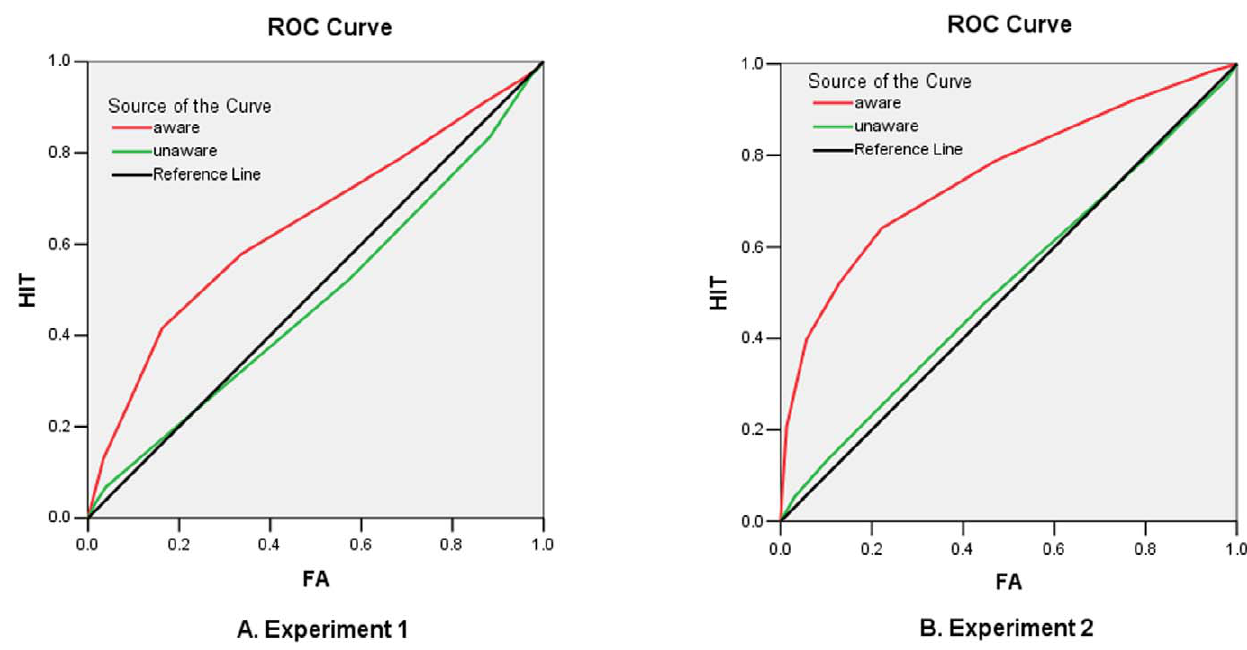
Figure 1. ROC curves for Experiment 1 and 2. The ROC curves were obtained by computing the cumulative Hit and False Alarm rates for each confidence level across participants in unaware and aware groups. The curves for unaware and aware groups were different in both experiments (left for Experiment 1 and right for Experiment 2).